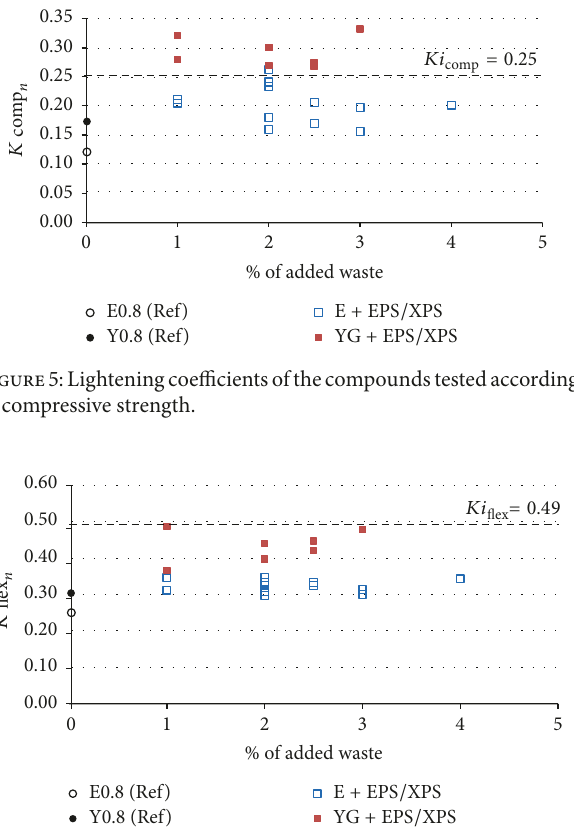
Figure 6: Lightening coefficients of the compounds tested accord- ing to flexural